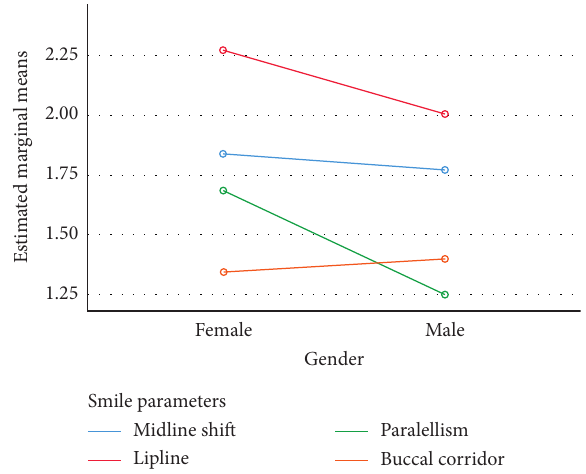
Figure 3: Plot of the mean score for smile parameters and